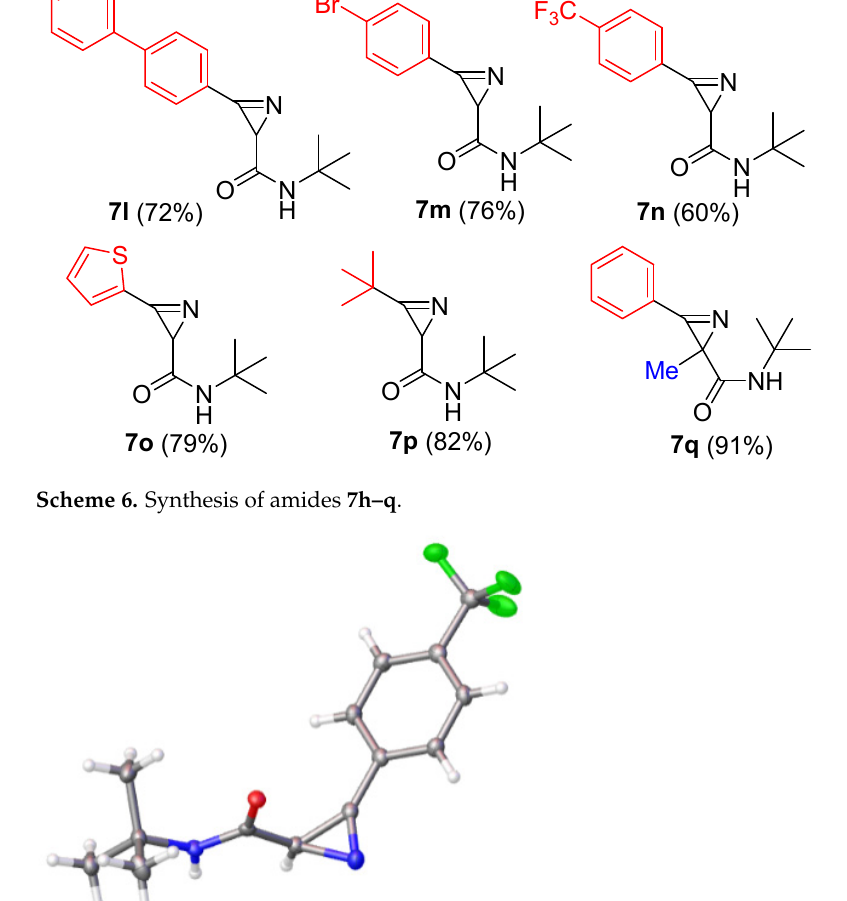
Figure 2. Perspective view of amide 7n showing thermal ellipsoids at 50% probability level. Additionally, 2 H -azirine-2-carbonyl chloride 1a was reacted with alkyl- and aryl- substituted O- and S-nucleophiles, such as phenol 12a , methyl 2-(2-hydroxyphenyl)acetate 12b , propargyl 12c , and benzyl 12d alcohols, as well as thiophenol 13a , cyclopentanethiol 13b , and N -(sulfanylmethyl)benzamide 13c . The reactions were carried out under standard conditions but used 1.5 equiv. of O- or S-nucleophile and with the DMAP addition to trap HCl. Azirinecarboxylic esters 14a-d were obtained in 77-92% isolated yields (Scheme